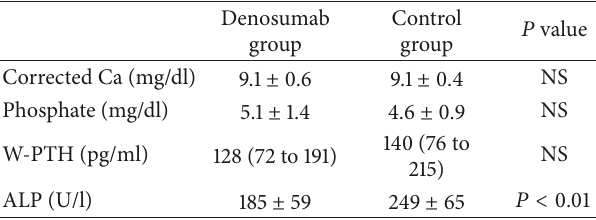
Table 5: Parameters of the patients at 12 months.